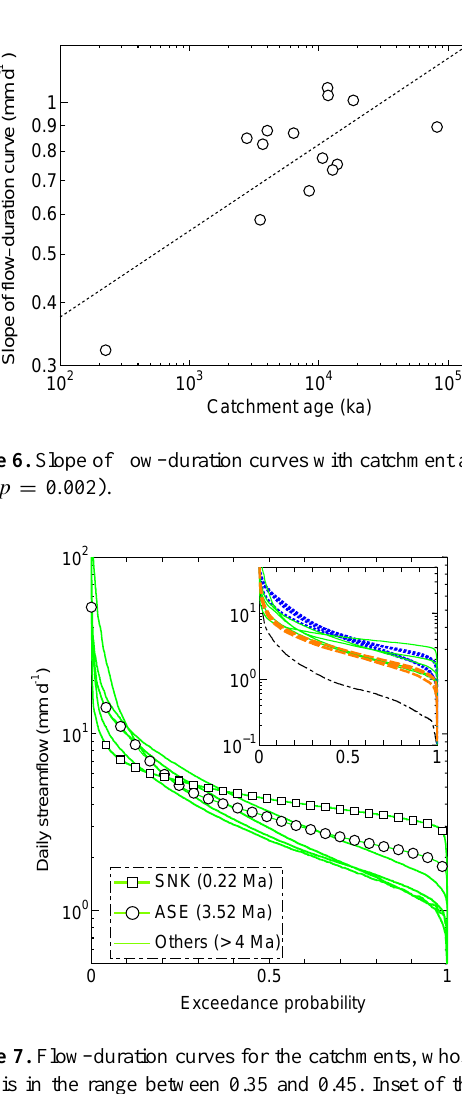
seasonal index (SI) (Walsh and Lawler,